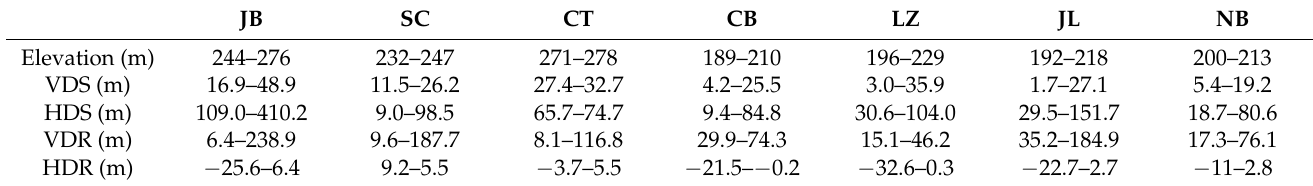
Table 2. The ranges of spatial indicators of seven WSMCs. VDS = vertical distance from the shoreline. HDS = horizontal distance from the shoreline. VDR = vertical distance from the road. HDR = horizontal distance from the